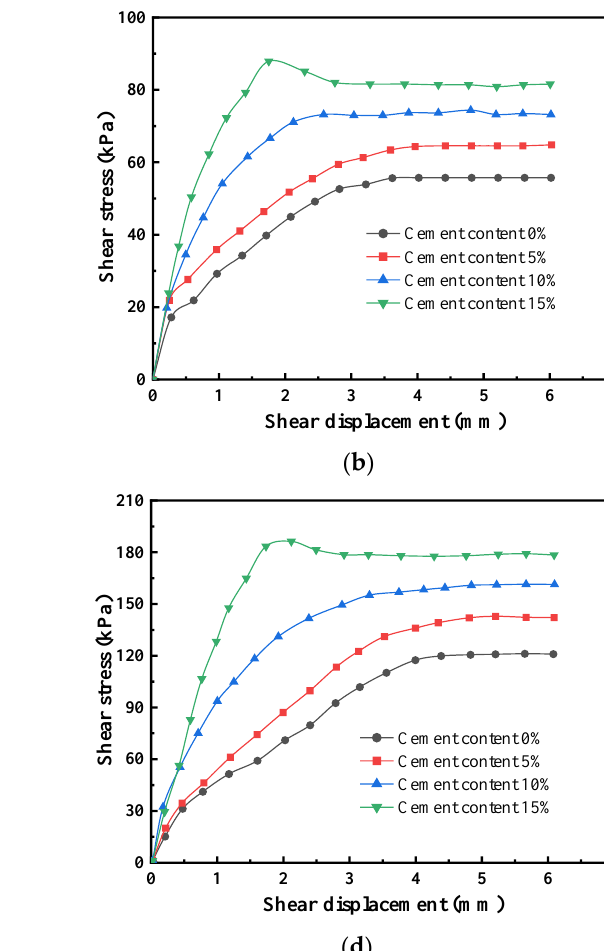
( b ) Figure 7. Shear strength of soil around the permeation grouting piles under different cement con- tent. ( a ) Muddy clay. ( b ) Silty clay.